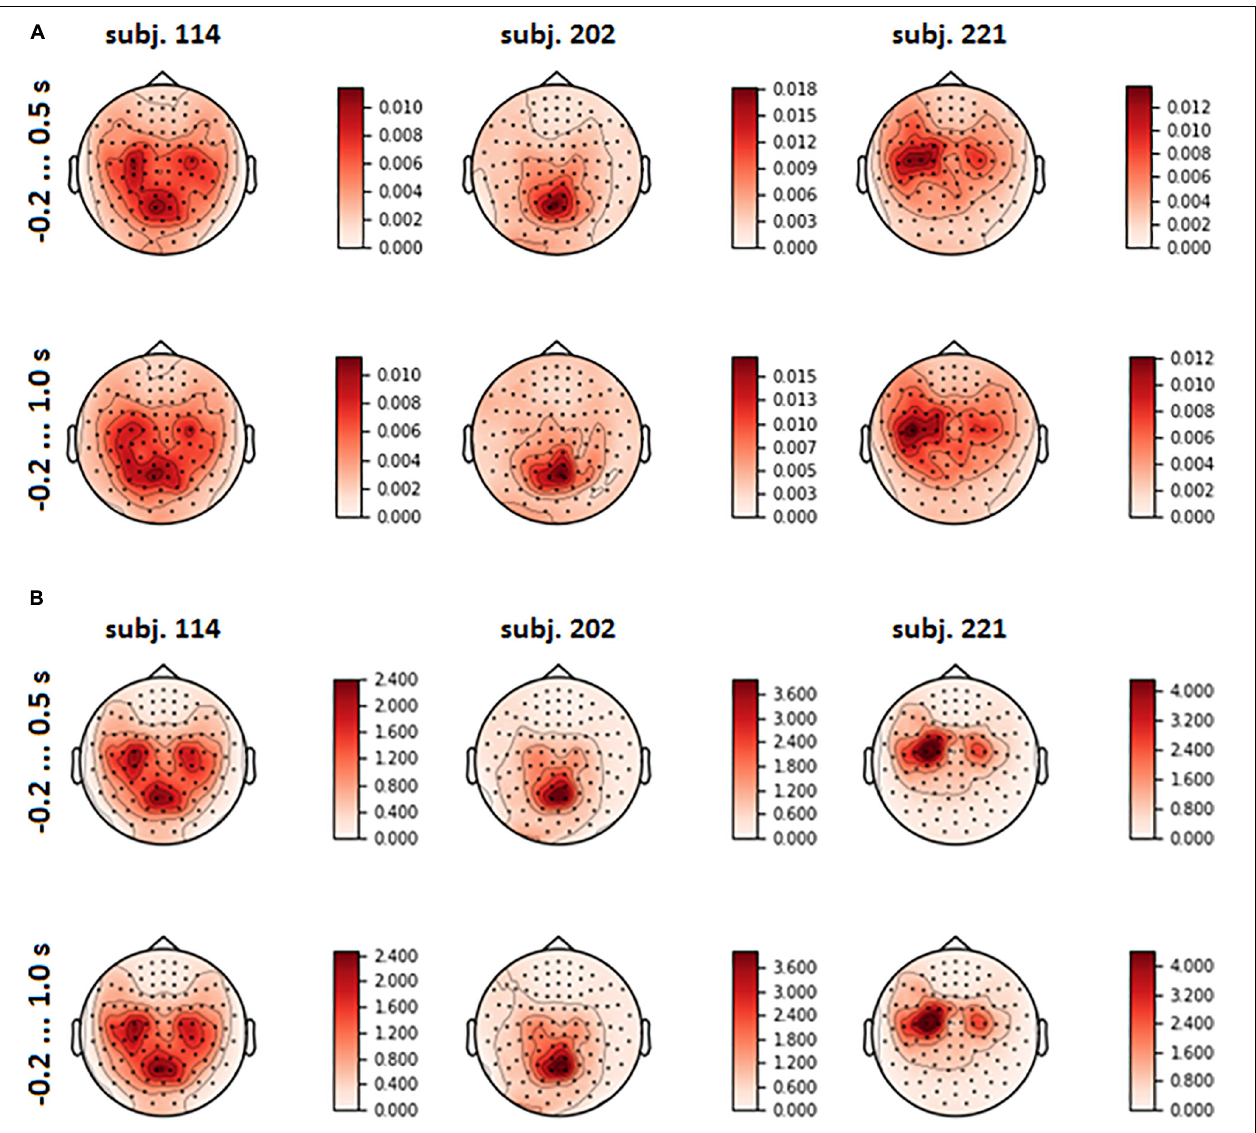
FIGURE 6 | Mean spatial pattern over LSs, averaged over test folds, for three participants who revealed distinct types of the patterns (A) ; input signal variance (B) .